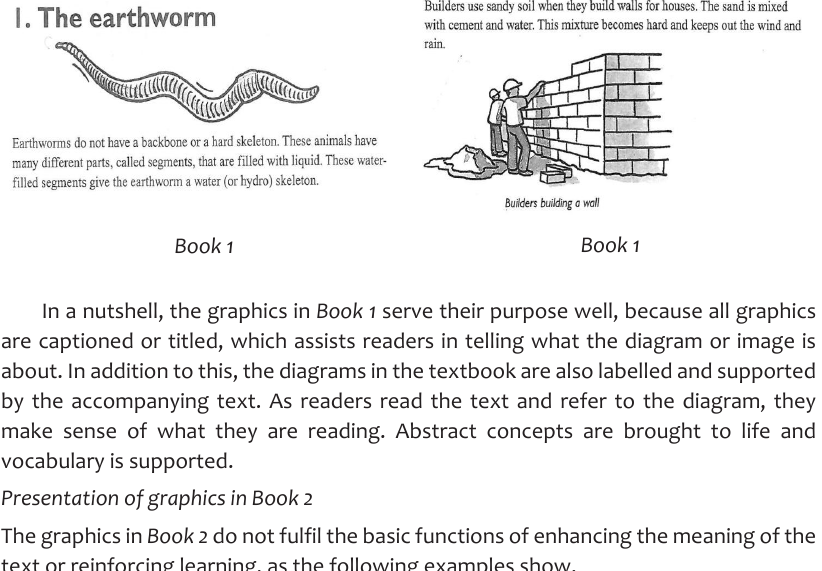
Figure 6: Picture supported by text